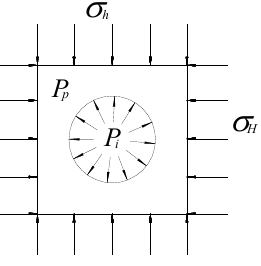
Figure 6. Two-dimensional mechanic model of shaft wall rock.